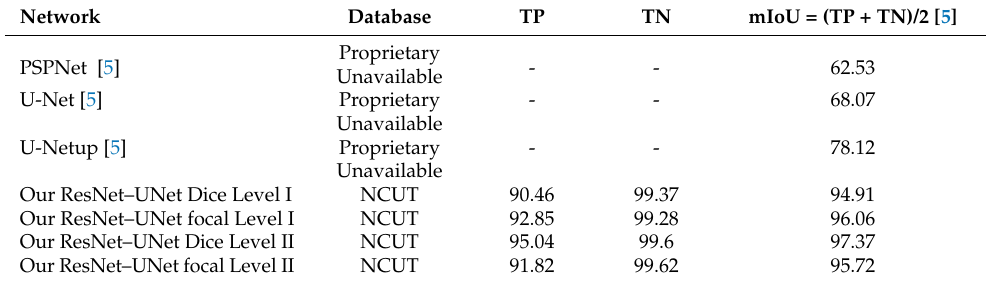
Table 6. Comparison of the results.